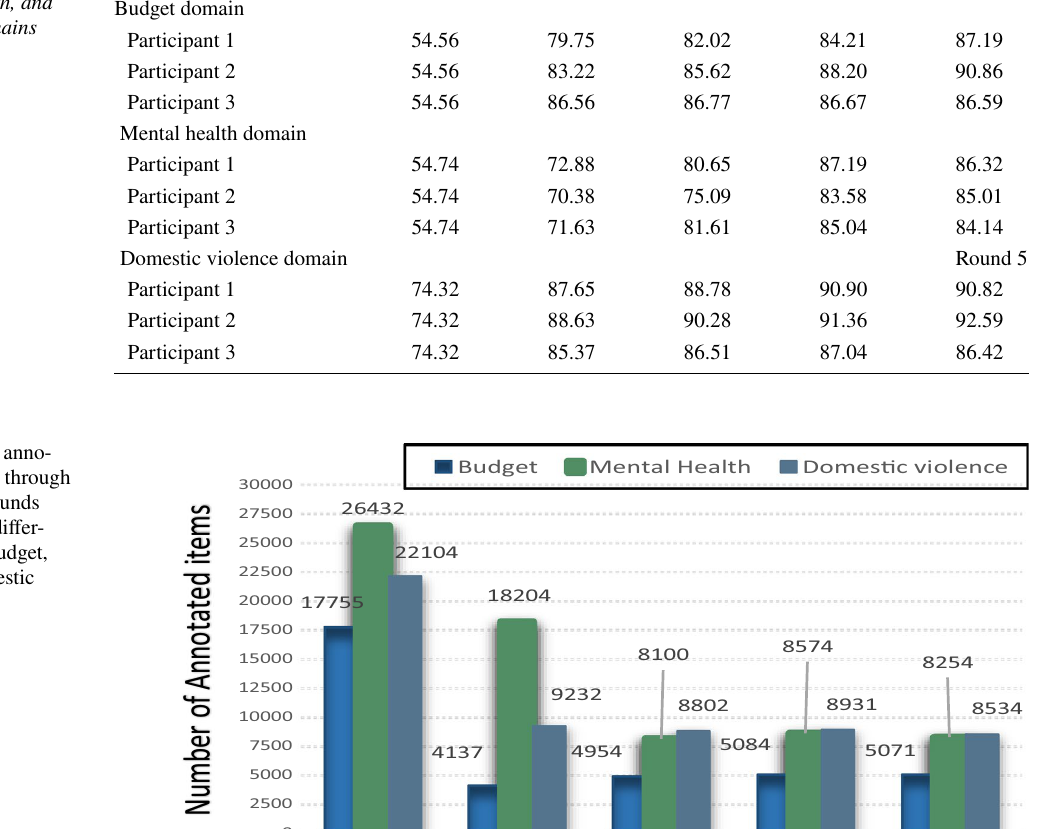
Table 3 Precision of rules adapted through participants in Budget, Mental Health, and Domestic Violence Domains